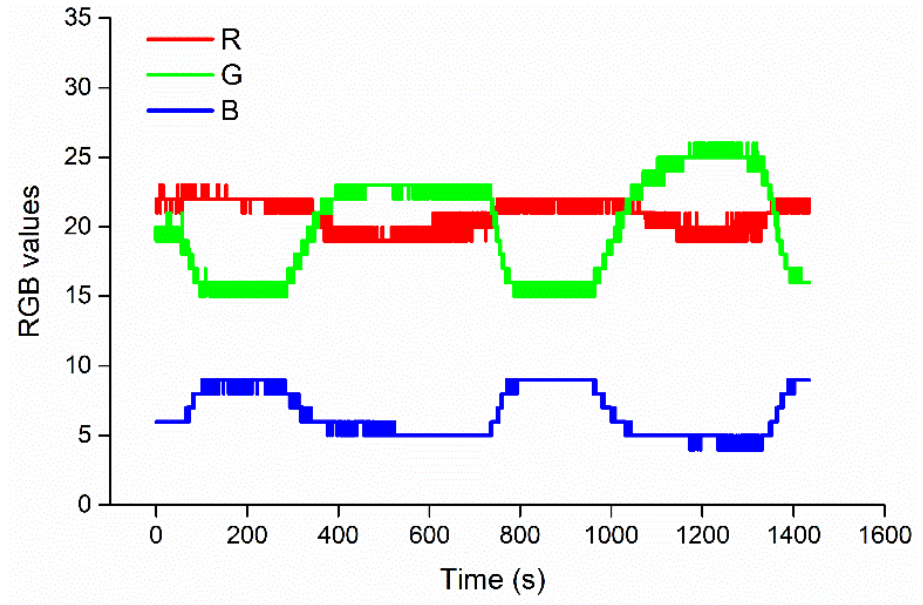
Figure 6. RGB kinetics of a PCN-224/PDMS film exposed to alternate cycles of methylamine and TFA.